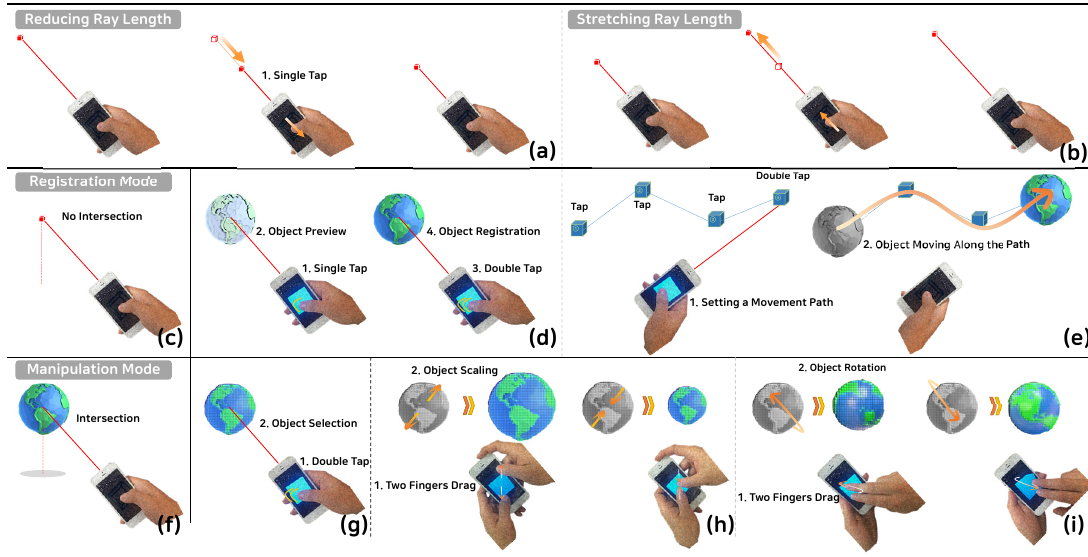
Figure 3. Object Manipulation. ( a ) Reducing ray length (depth). ( b ) Stretching ray length. ( c ) Registration mode (when nothing intersected). ( d ) Object registration. ( e ) Setting a movement path. ( f ) Manipulation mode (when object and ray’s end point intersected. ( g ) Object selection. ( h ) Object Scaling. ( i ) Object